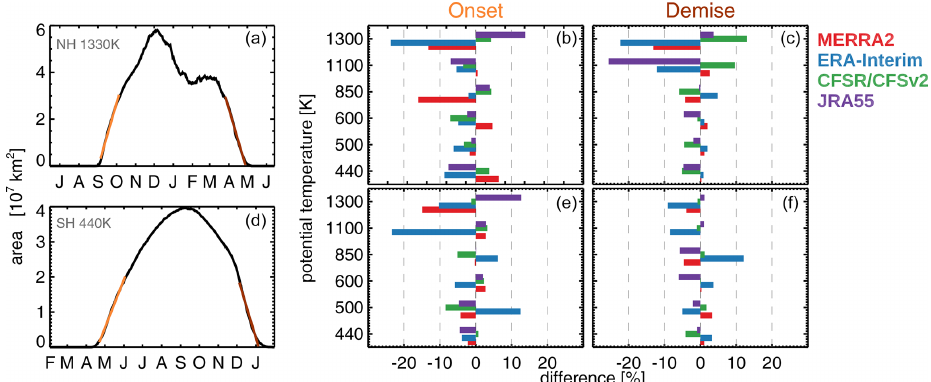
Figure 14. (a, d) Examples of the linear fits applied during onset and demise of the vortex in the REM (see text). (b, c, e, f) Percent difference between the linear fits’ slopes for each reanalysis from the REM; (b, c) Northern Hemisphere and (e, f) Southern Hemisphere.